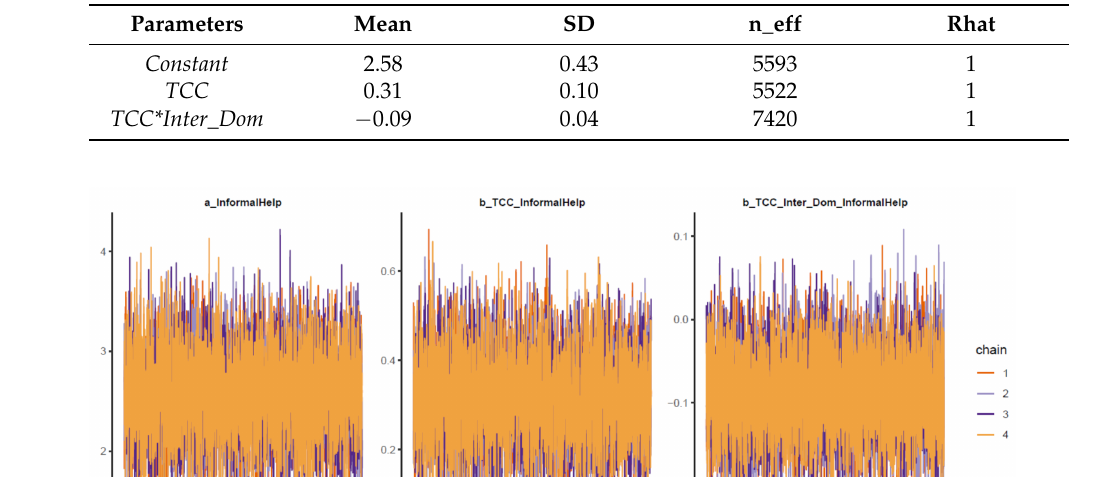
Table 3. Model 2 (cid:48) s simulated posteriors.